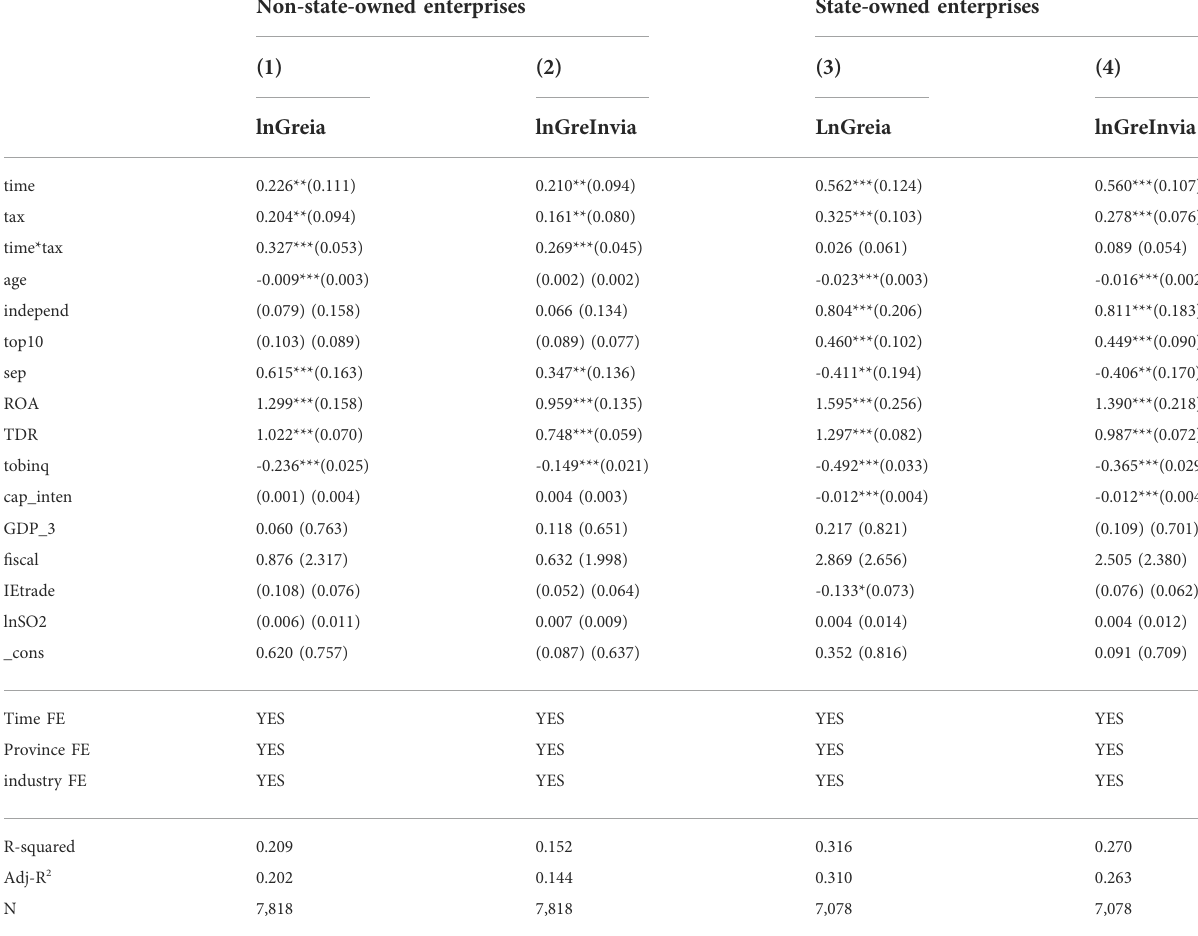
TABLE 6 Regression results for the sample by nature of